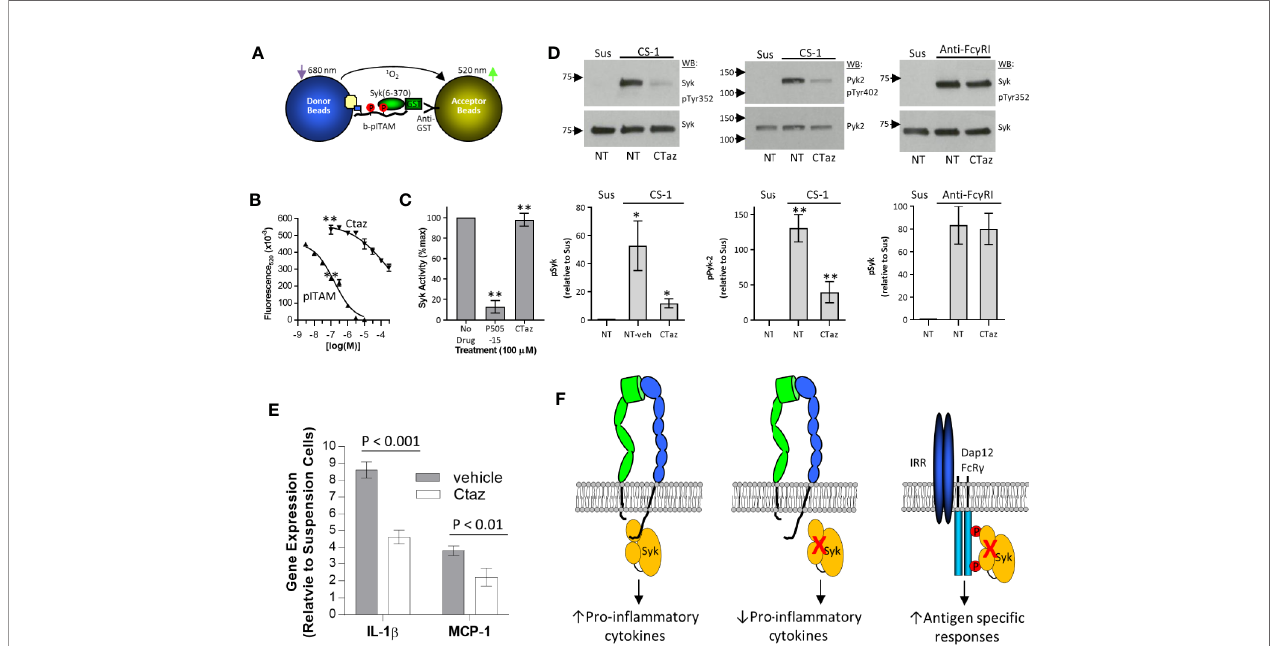
FIGURE 6 | Selective inhibition of integrin signaling by ceftazidime. (A) Schematic illustration of the pITAM-Syk AlphaScreen used to test antagonist selectivity. (B) Comparison between ceftazidime (Ctaz) and pITAM peptide inhibition of pITAM-Syk binding in the AlphaScreen assay described in (A) . Biotinylated pITAM peptide was used at 10 nM, and GST-Syk(6-370) was used at a fi nal concentration of 1 nM. Data are expressed as mean ± range from duplicate determinations. One of four representative assays is shown. (C) Effect of ceftazidime on Syk kinase activity. Ceftazidime (Ctaz) or Syk inhibitor P505-15 was used at 100 uM. Kinase activity is expressed as percent of maximum signal. Data are expressed as mean ± SEM (n = 3). **p < 0.01 (D) Selective effects of ceftazidime on integrin signaling. Ceftazidime (Ctaz; 100 uM)-loaded THP-1 or mock-loaded control cells (NT) were either maintained in suspension (Sus) or incubated on immobilized CS-1 (left and center panels) or anti-Fc g RI monoclonal antibody 276426 (right panel). Phosphorylation of Syk (left and right panel) and Pyk-2 (center panel) was analyzed by immunoprecipitation and western blot. One representative blot is shown. Quanti fi cation is shown below (left panel, n = 5; center panel, n = 3; right panel, n = 3), normalized to phosphorylation in suspension. Results are expressed as the mean ± SEM. ANOVA Tukey post-hoc analysis; *p < 0.05; **p < 0.01. (E) Similar to (D) , cells were loaded with ceftazidime (Ctaz; 100 uM) or mock-loaded and kept in suspension or plated on CS-1. Expression of interleukin (IL)-1 b and monocyte chemoattractant protein (MCP)-1 genes was examined by quantitative real-time polymerase chain reaction. Data are expressed as expression levels relative to control cells kept in suspension. Results are shown as the mean± SD. P-values were calculated by the Student t test. (F) Cartoon representation of integrin and immune response receptor signaling via